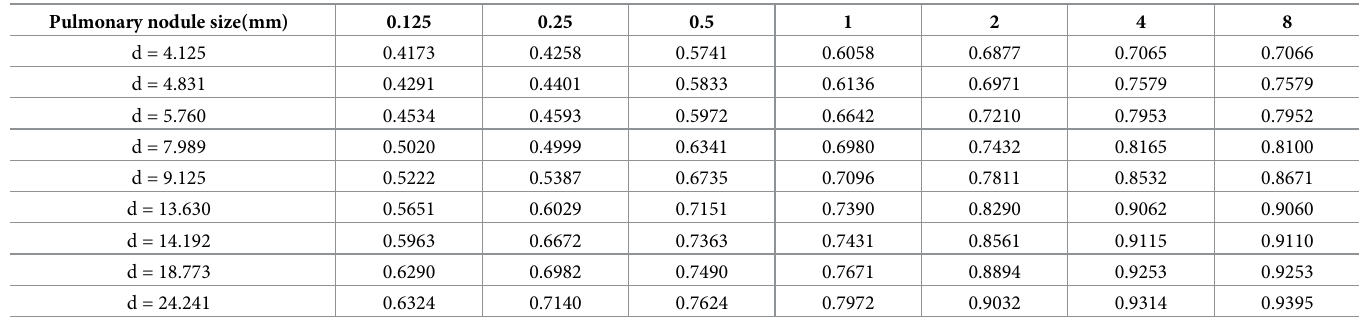
Table 8. Accuracy pulmonary nodules of different scales in different false positive rates.